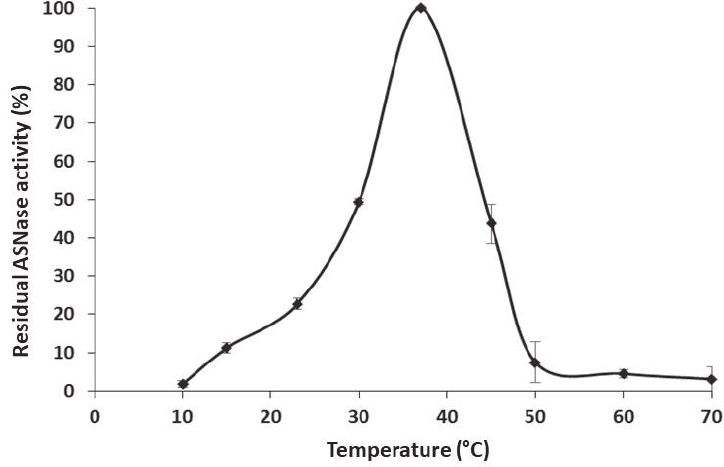
Fig. 2 – Effect of temperature on l -asparaginase from Enterobacter sp. strain